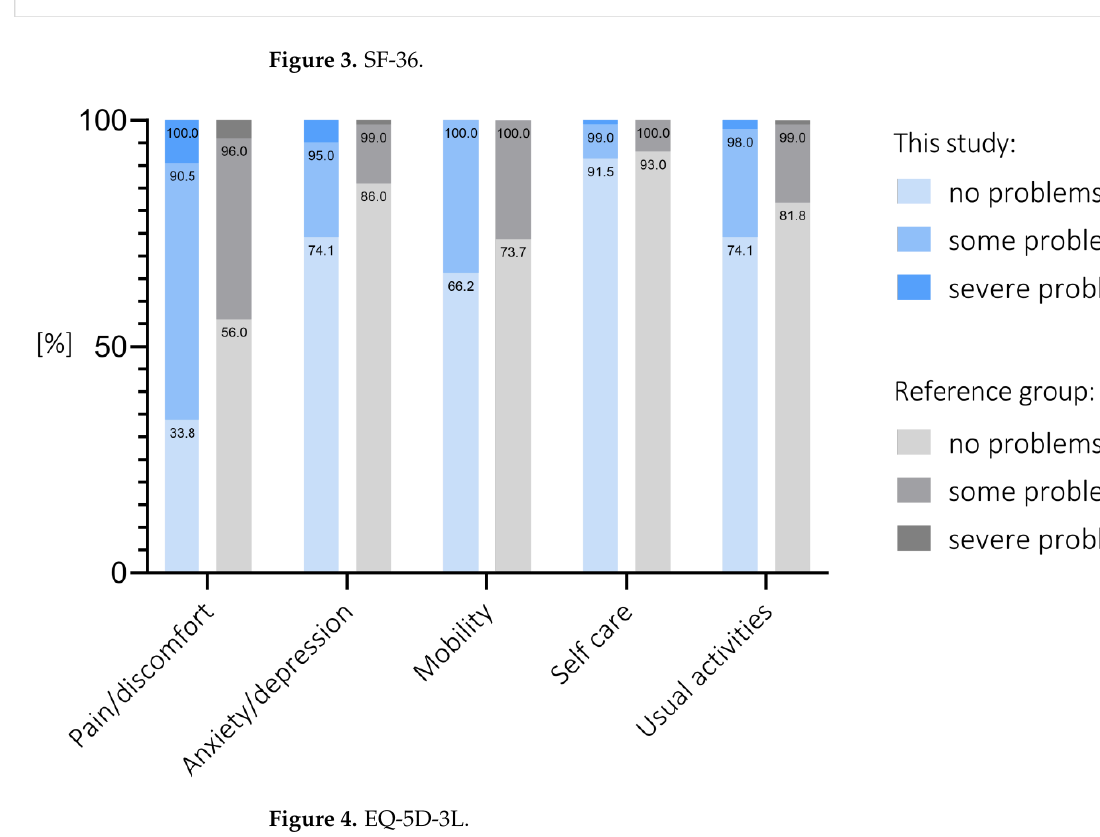
Figure 4. EQ-5D-3L